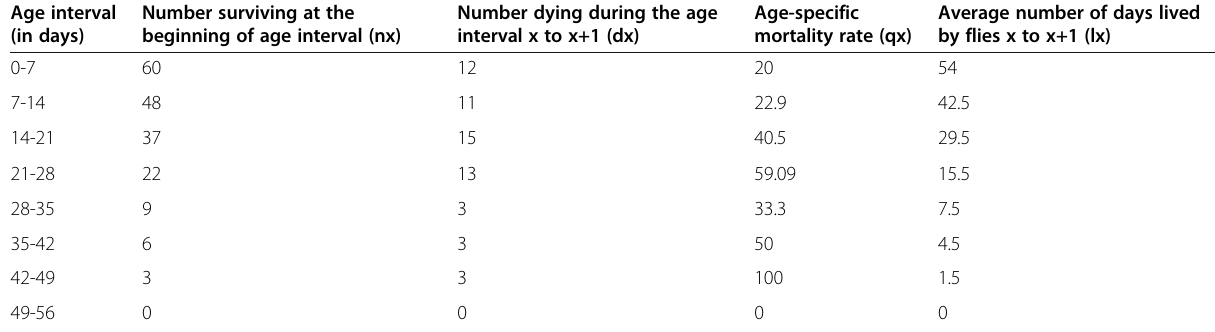
Table 5 Life table depicting survival of D. melanogaster in medium with tulsi extract+0.8 mg/L NaF Age interval Number surviving at the (in days) beginning of age interval (nx)